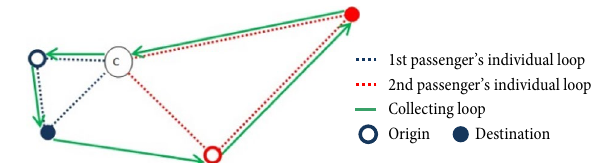
Fig. 1. The illustration of the first step of case No. 1